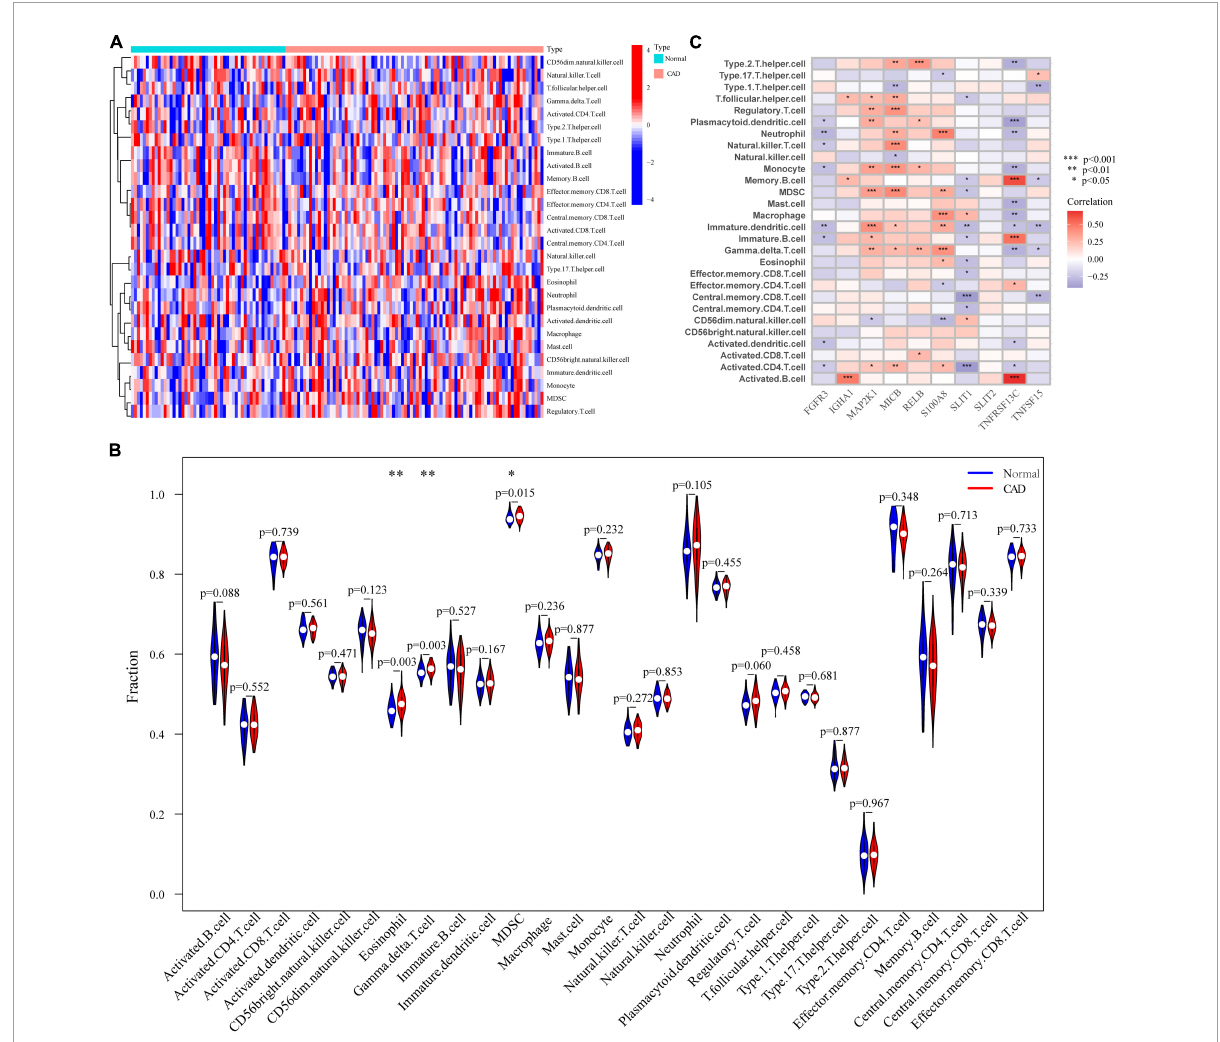
FIGURE5 Analysis of the immunological landscape. (A) Immune cell expression levels in samples from healthy individuals and CAD patients. (B) Comparison of immunological microenvironments in CAD patients and healthy samples. (C) Differential study of the immunological microenvironments caused by single genes in OFGs. ∗ p < 0.05, ∗∗ p < 0.01, ∗∗∗ p <